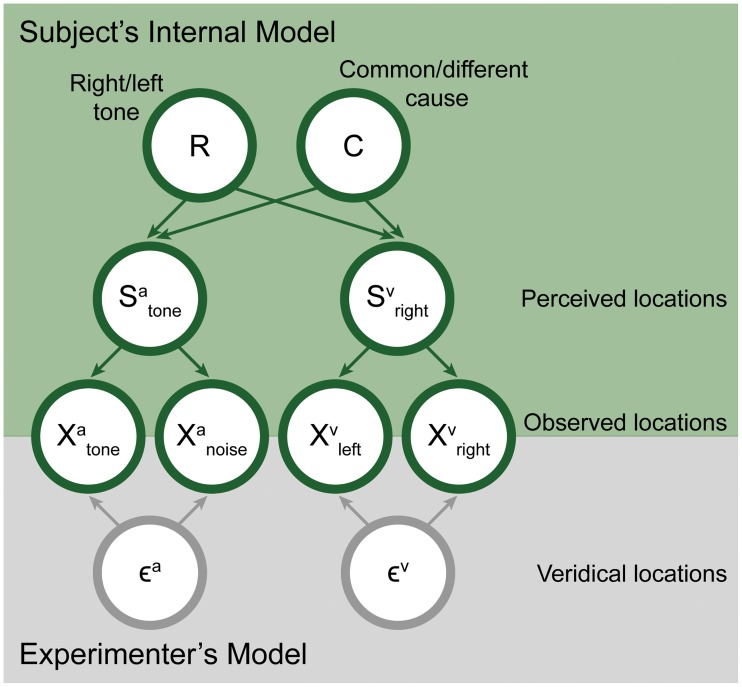
Graphical depiction of our model schematic.Our full model contains two generative models. The first one is the experimenter’s model which maps the true task variables to the sensory observations made by the subject. The second is the subject’s internal model of the sensory observations which is used the subject’s perception (Inference in the generative model).